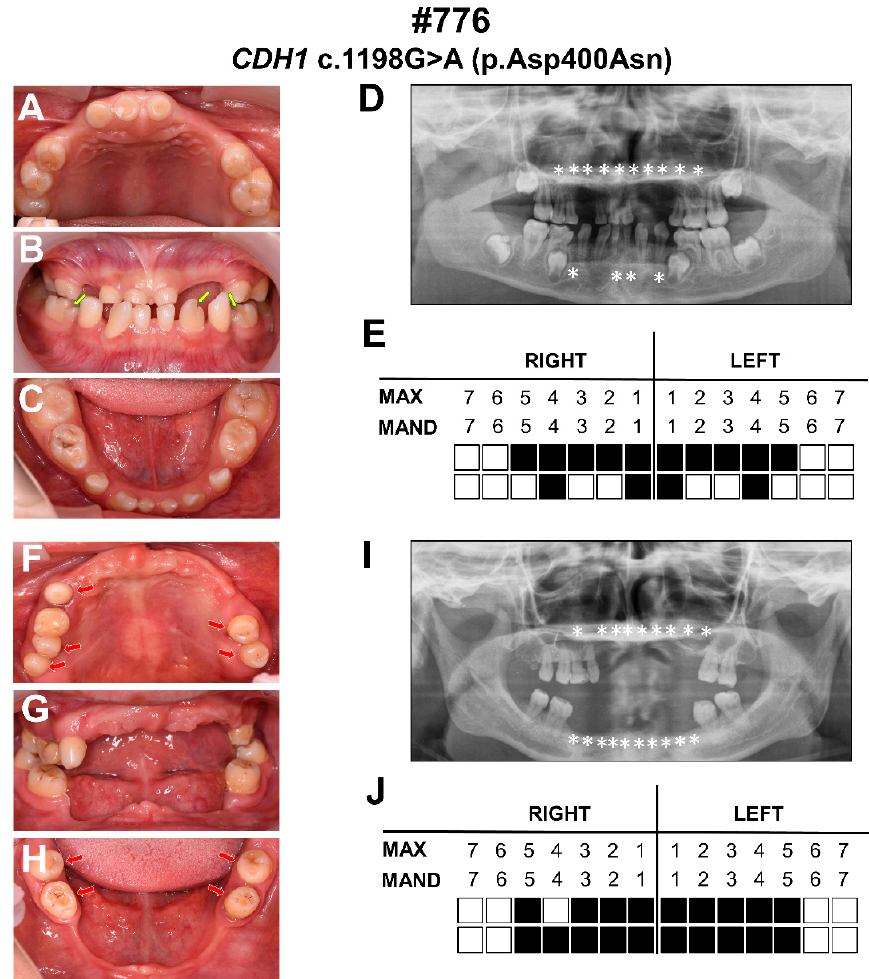
Figure 1. Clinical photographs and panoramic radiographs of the proband and his mother. ( A – C ) Intro-oral photographs of the proband. ( D ) Panoramic radiograph of the proband. ( E ) Schematic of congenital missing permanent teeth of the proband. ( F – H ) Intro-oral photographs of the proband’s mother. ( I ) Panoramic radiograph of the proband’s mother. ( J ) Schematic of congenital missing permanent teeth of the proband’s mother. Asterisks and solid squares indicate congenitally missing teeth; the yellow arrows indicate teeth with notching of the incisal edges; the red arrows indicate conical-shaped teeth. Max: maxillary; Mand: mandibular.